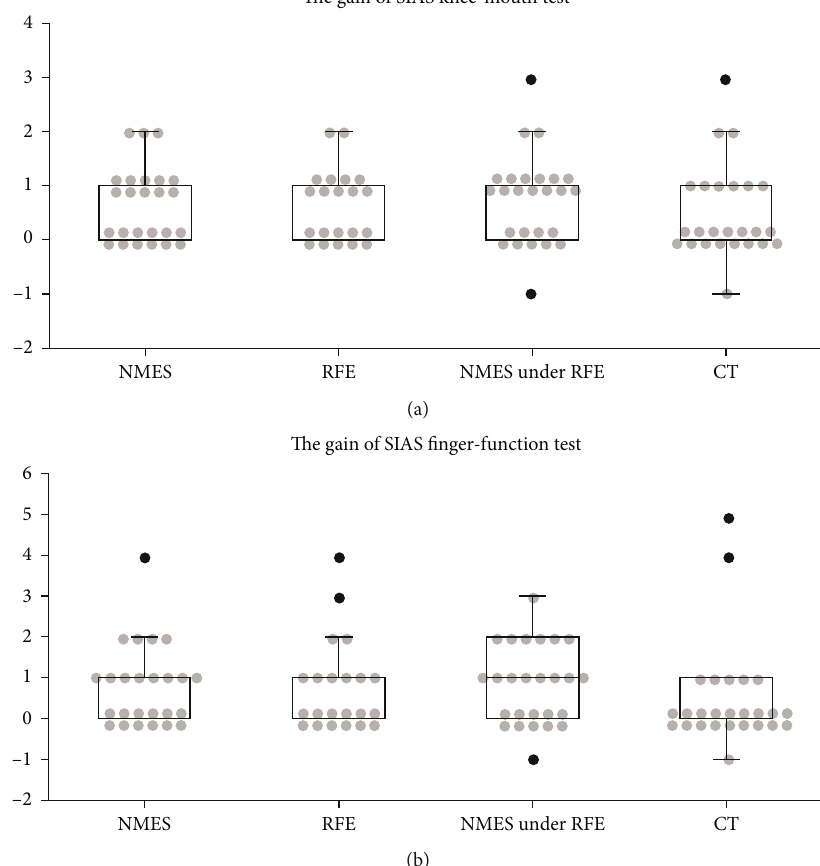
Figure 2: SIAS gain comparison of each group. SIAS: Stroke Impairment Assessment Set; NMES: neuromuscular electrical stimulation; RFE: repetitive facilitative exercise; CT: conventional training. (a) SIAS Knee-Mouth test, (b) SIAS Finger-Function test. Scatter plot (circles: individual patients) and box-and-whisker plot (minimum, quartiles, and maximum) of SIAS gain in each group, black circle: outliers over 1 : 5 × interquartile range . No signi fi cant di ff erences were observed between